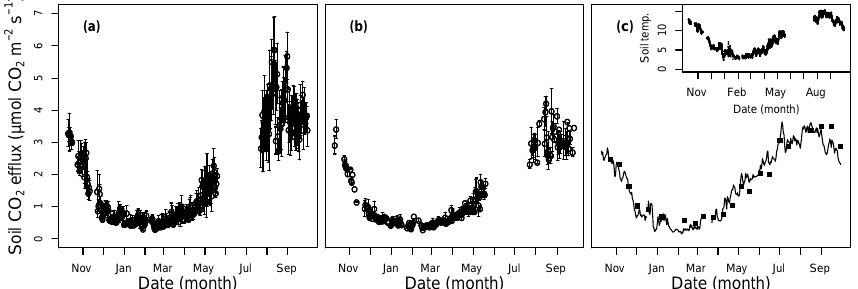
Figure 6. Comparison of the courses of the mean daily soil CO 2 efflux throughout the year. Panels (a, b) show mean daily soil CO 2 effluxes ( ± standard deviation) throughout the year measured by the eight automated soil chambers, without friction velocity ( u ∗ ) filtering and with a u ∗ threshold values of 0.7 respectively. (c) The black dots show the mean soil CO 2 effluxes for each of the manual soil chamber campaigns, and the solid line shows the output of the empirical model based on these manual measurements. The course of soil temperature throughout the year at 5cm depth measured at the eight automated chambers is shown on the inset in (c)